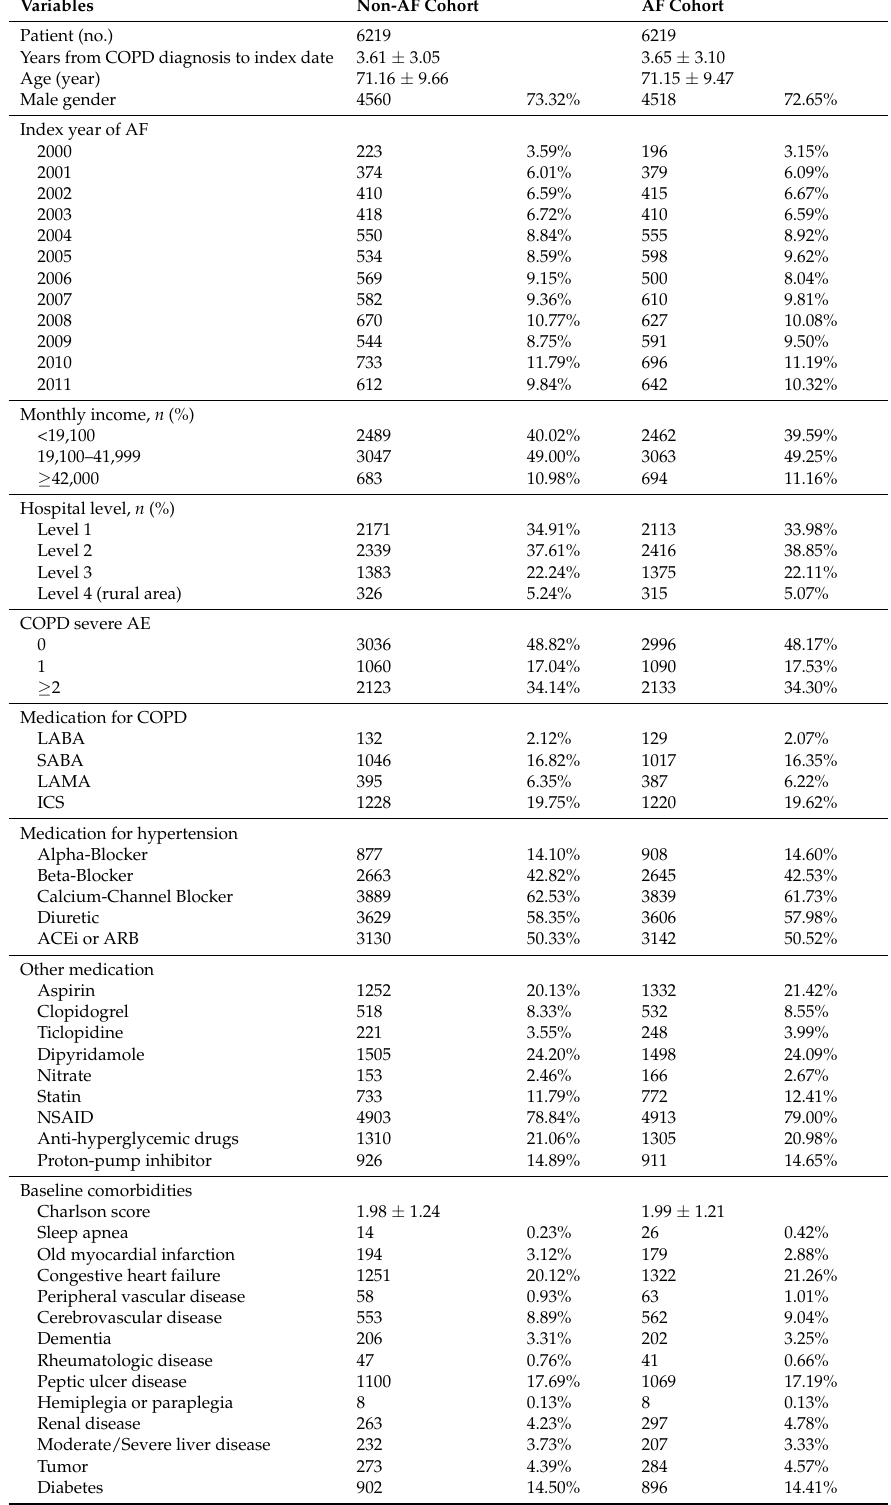
Table 1. Demographic and clinical characteristics of the chronic obstructive pulmonary disease (COPD) patients with and without Atrial Fibrillation (AF). Variables Non-AF Cohort AF Cohort Patient